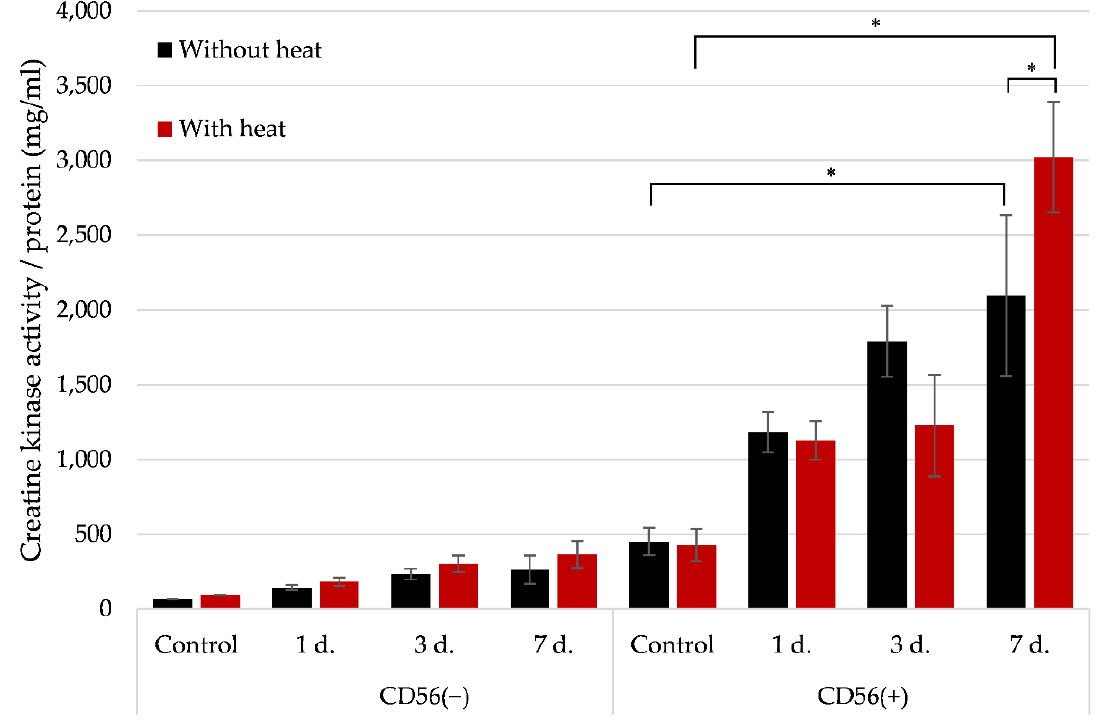
Figure 8. The effect of heat stimulus on creatine kinase activity in CD56( − ) and CD56(+) cells. The CD56( − ) and CD56(+) cells were heat stimulated (42 ◦ C for 1 h and 2 h of recover) and exposed to the myogenic differentiation medium for 1, 3 and 7 days. The creatine kinase (CK) activity was measured as described in the method part. Data are shown as mean ± standard deviation (SD) and are significant at * p ≤ 0.05 from not less than three repeats ( n = 3) and two cell cultures using the Excel